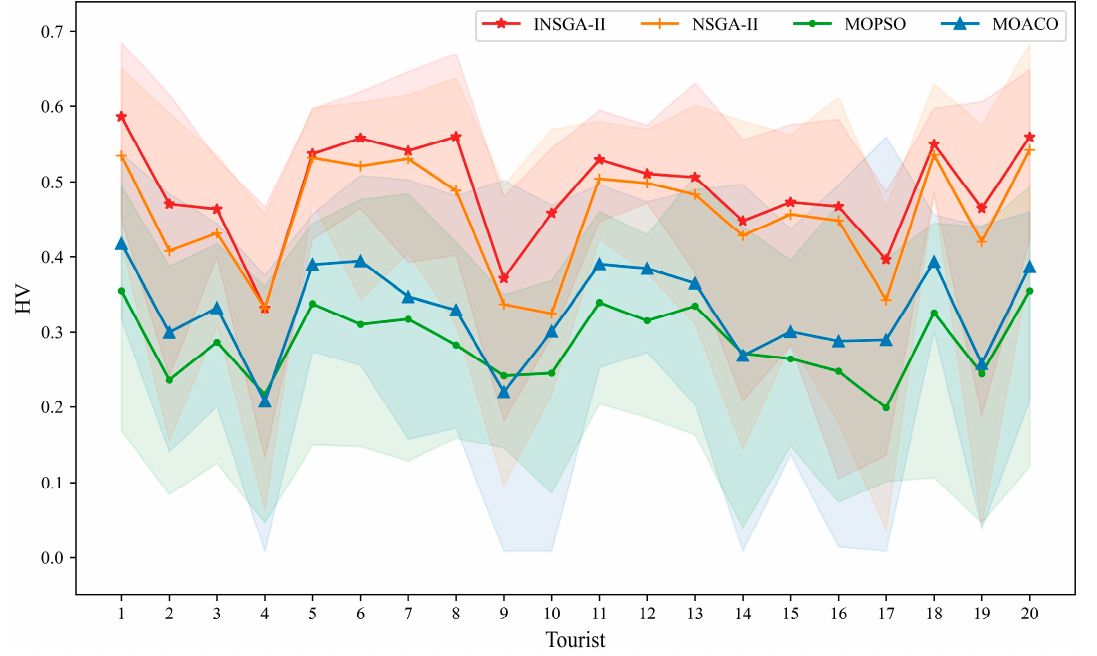
Figure 11. The comparison of average, maximum, and minimum HV values for 20 different tourists (INSGA-II, NSGA-II, MOPSO, and MOACO).